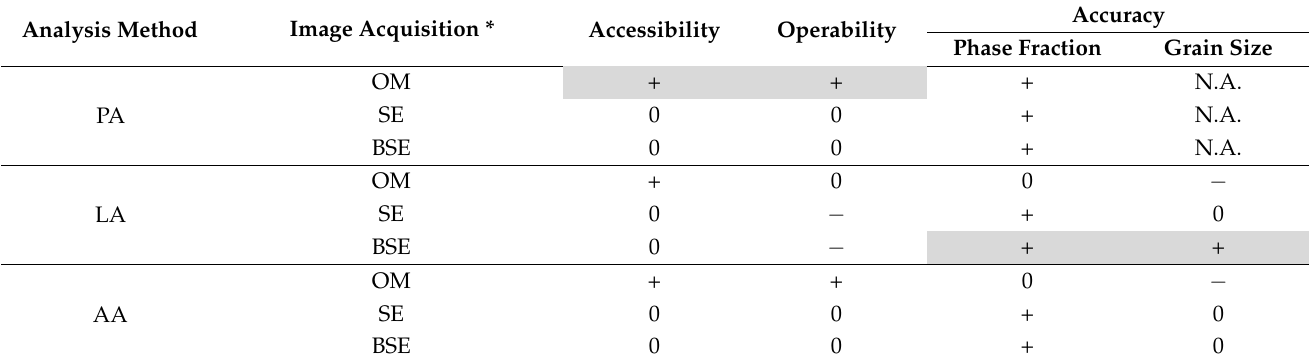
Table 14. Evaluation of the characterization and analysis methods for the one-phase